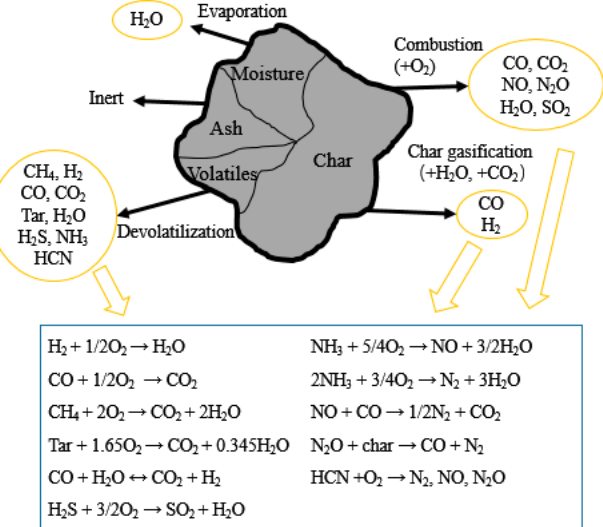
Figure 1. Main reactions of the powder coke combustion process.